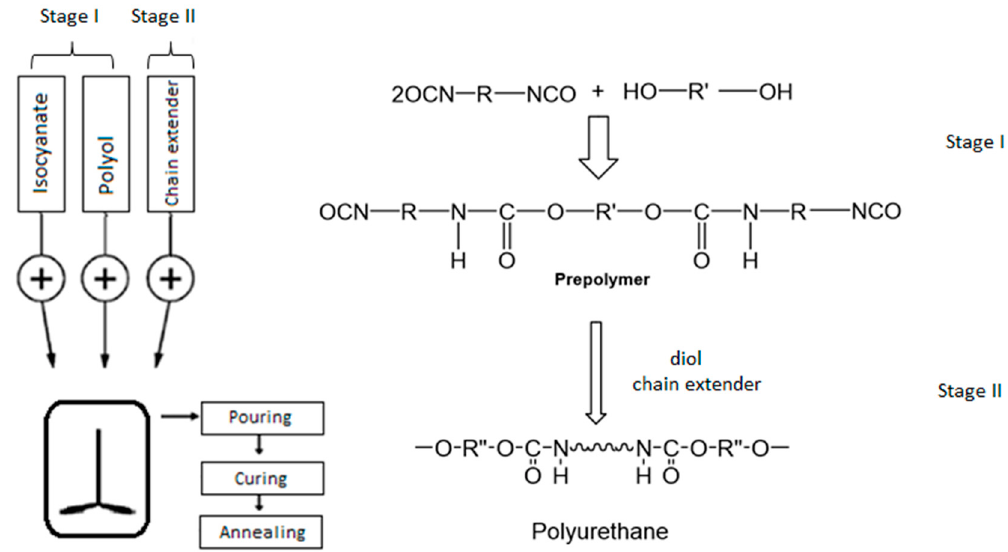
Figure 1. Schematic representation of the synthesis process and the reaction using a two-step polymerization method.